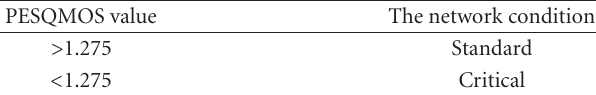
Table 3: Decision level for the relevant network